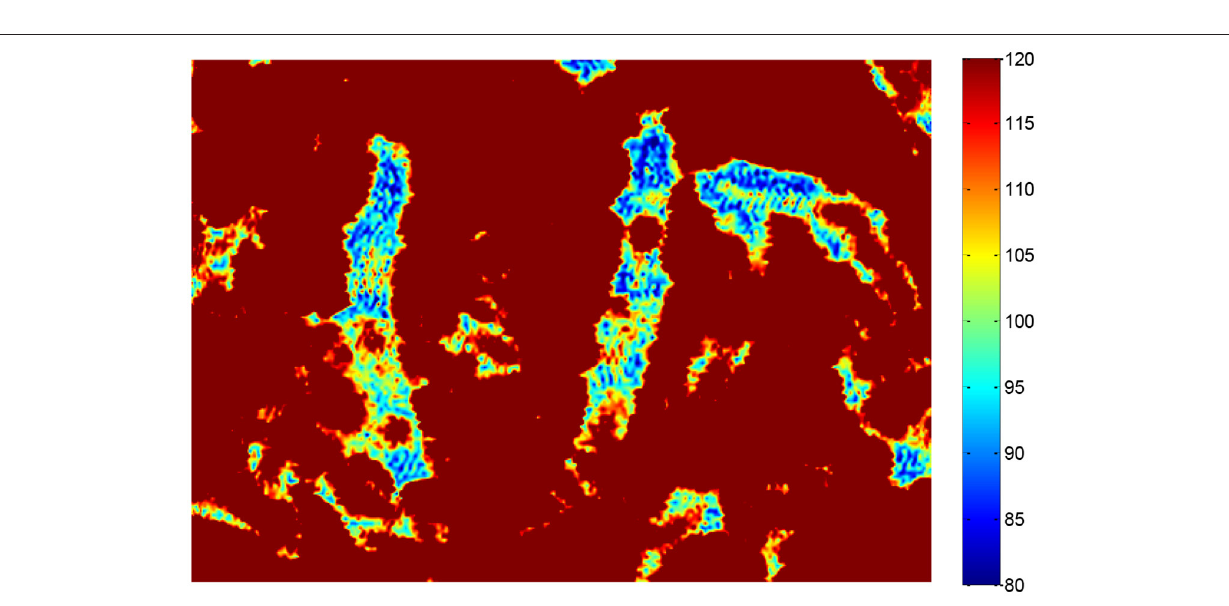
Frontiers in Nutrition |